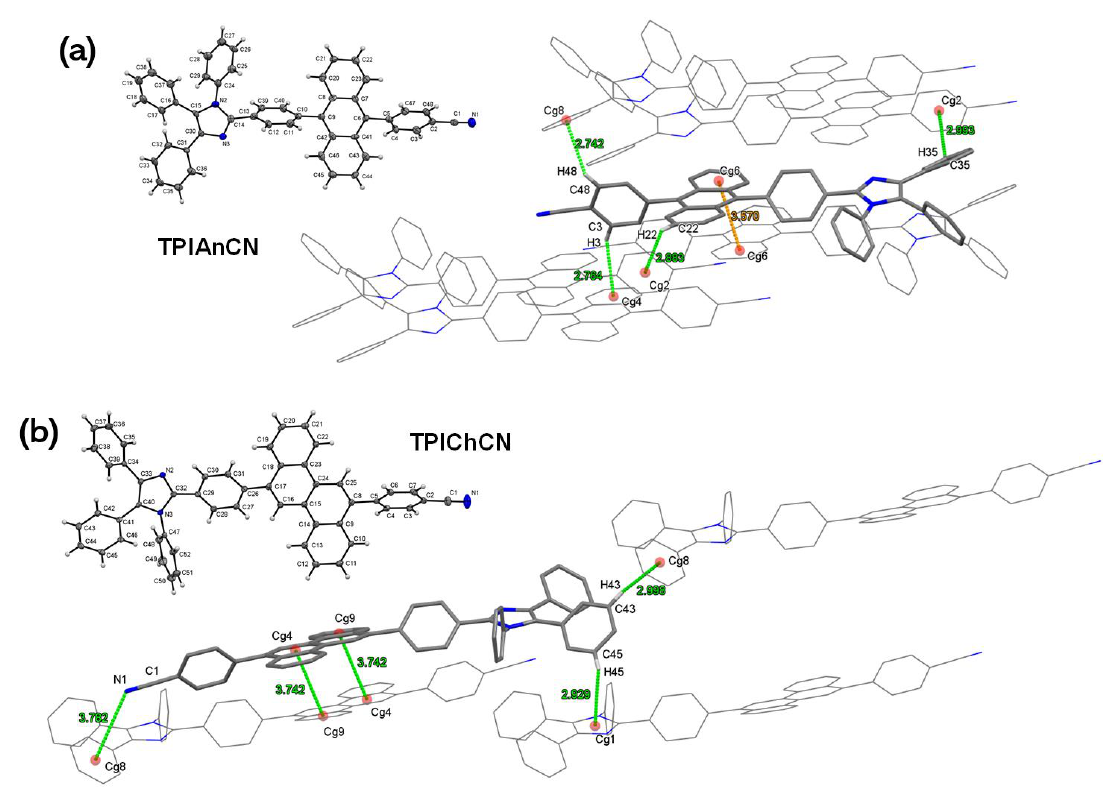
Figure 1. Single crystal structures (thermal ellipsoids at the 50% probability) and crystal packing of ( a ) TPIAnCN and ( b ) TPIChCN (C-H- π (green), π - π (orange), and lp - π (pink) interactions).